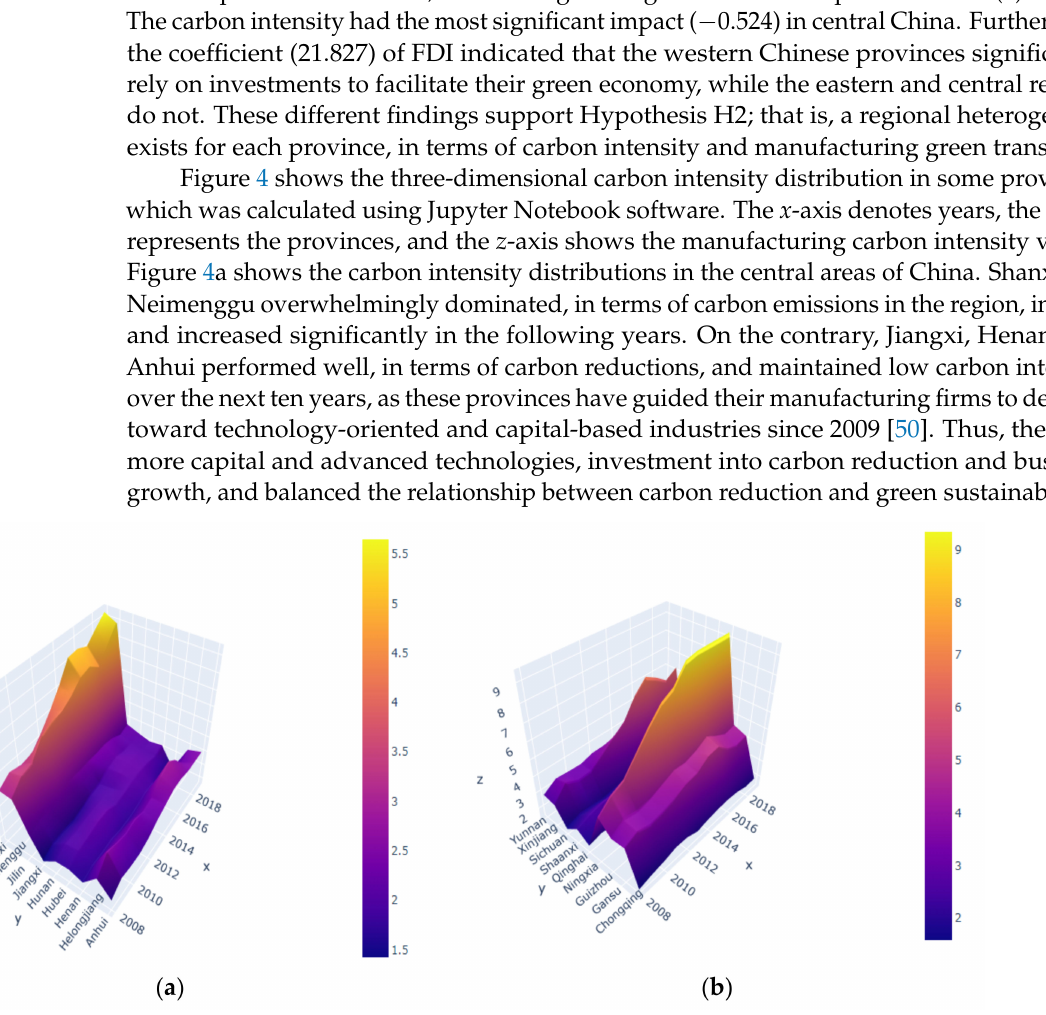
Figure 4. The distribution of the manufacturing carbon intensity in central ( a ) and western ( b ) provinces of